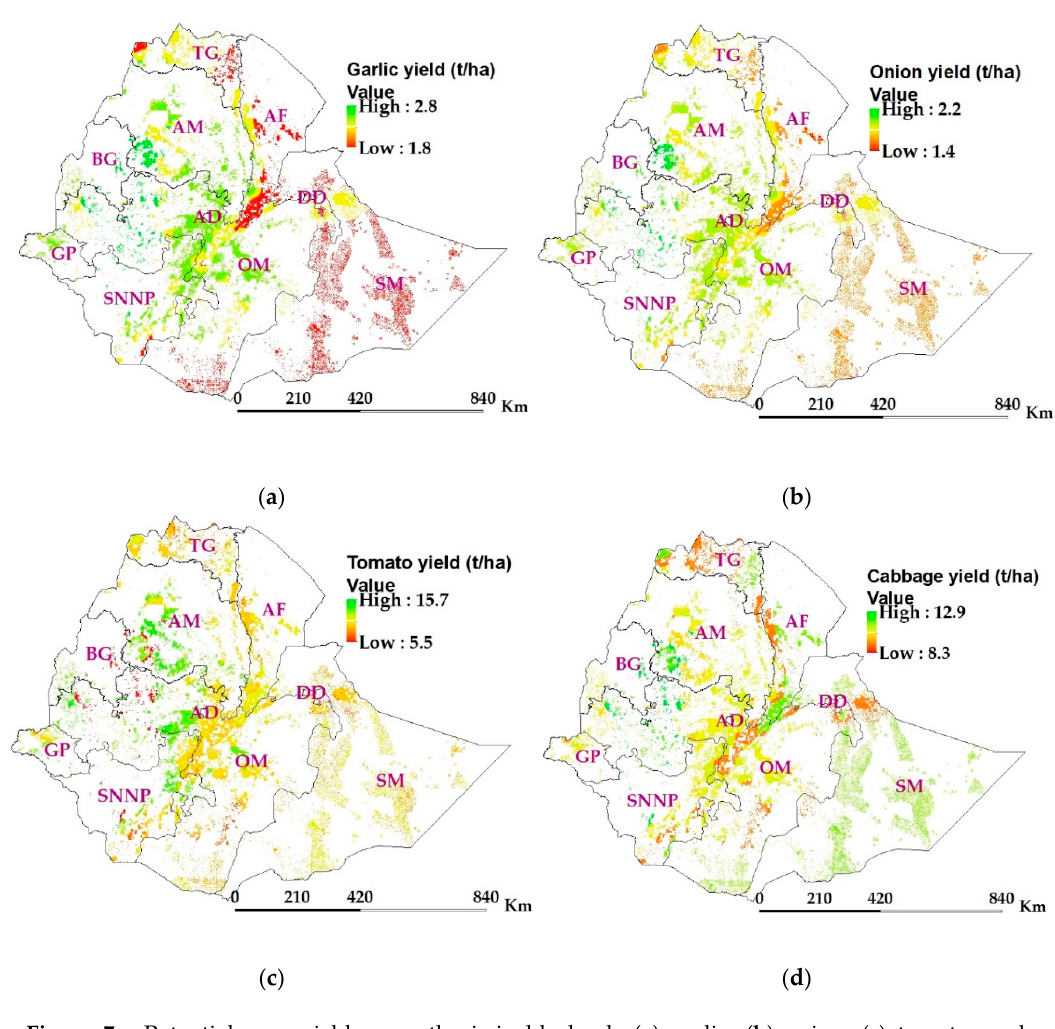
Figure 7. Potential crop yields over the irrigable lands ( a ) garlic, ( b ) onion, ( c ) tomato, and ( d ) cabbage. Abbreviations in the map are administrative regions (TG—Tigray, AM—Amhara, AF—Afar, BG—Benshangul Gumaz, AD—Addis Ababa, DD—Dire Dawa, GP—Gambela Peoples, SNNP—Southern Nations, Nationalities and Peoples, and SM—Somali).